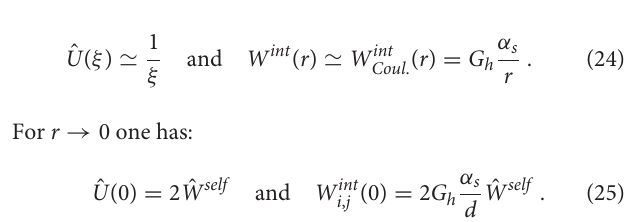
The function U ( ξ ) is calculated numerically for the ˆ different